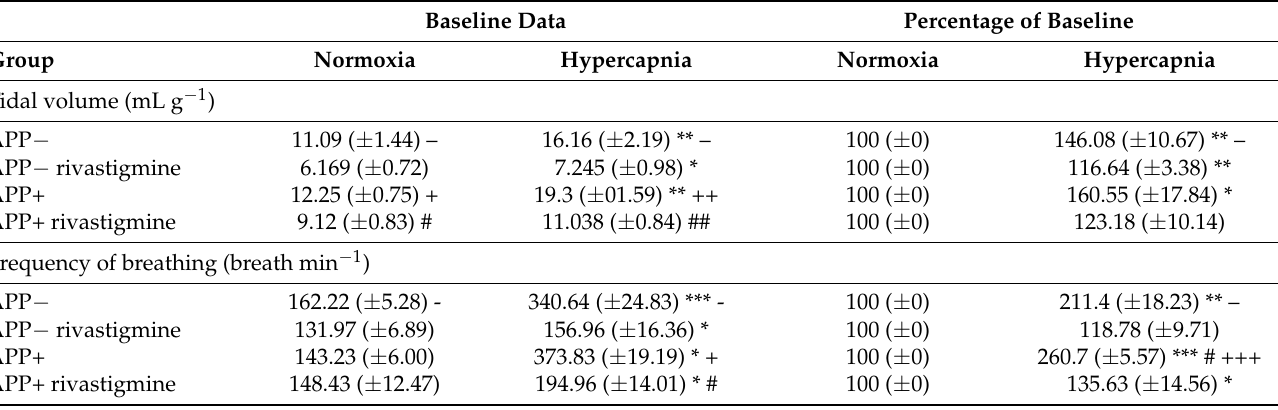
Table 5. Tidal volume (V T ) and frequency of breathing (F) baseline values during air breathing (normoxia) and hypercapnia in APP+ and APP − mice before and after rivastigmine injection. In the two right columns, V T and F during the respiratory response to hypercapnia are expressed as a percentage of baseline values in normoxia.